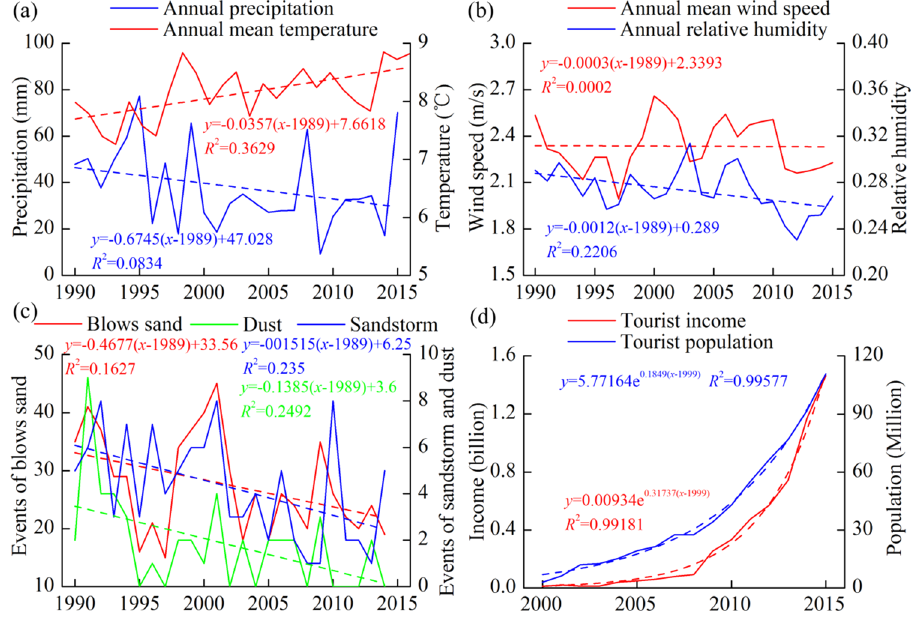
Fig. 6 The climatic and ecologi- cal changes and tourism devel- opment ( a the precipitation and temperature; b wind speed and relative humidity; c blows sand, sandstorm and dust; d tourism